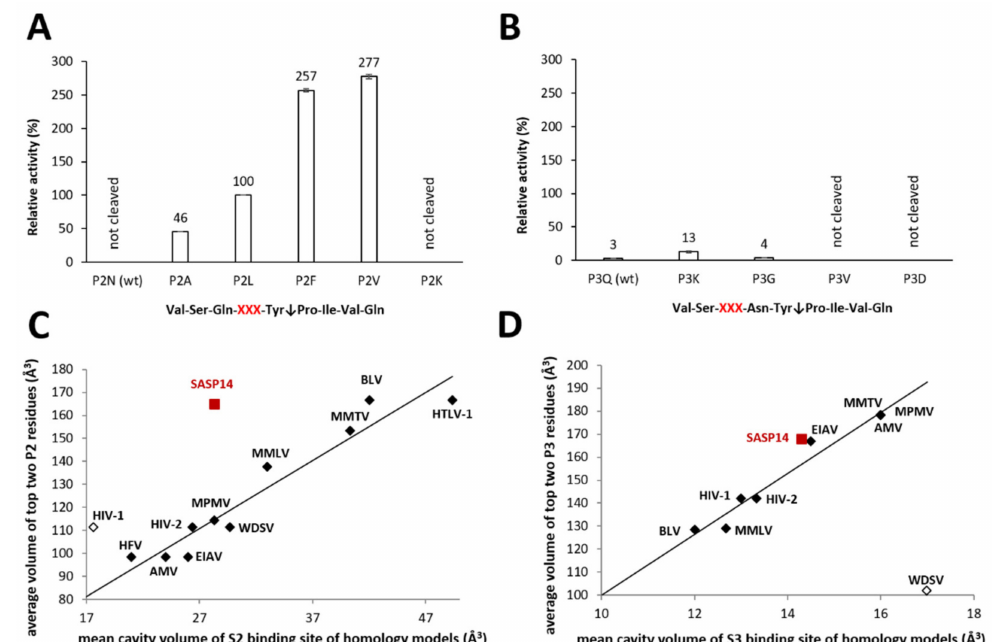
Figure 6. P2- and P3 residue preferences of GST-SASP14. The synthetic oligopeptides used for activity measurements represented wild-type and P2- or P3-modified variants of HIV-1 MA / CA (VSQNY ↓ PIVQ) cleavage site, modified positions are indicated by XXX. Relative activities were determined for the wild-type substrate and for its P2- ( A ) and P3-modified variants ( B ) by incubating reaction mixtures for 1 and 16 h, respectively. Activity determined for P2-Leu variant was considered to be 100%. Error bars indicate SD ( n = 2). Figure part ( C , D ) was prepared in part based on previously published data [24,25]: the average volumes of two residues for which the measured relative activity was the highest are plotted against the mean cavity volumes of S2 ( C ) and S3 subsites ( D ) of various retroviral proteases. Values determined for SASP14 are shown by red squares, values of previously published dataset are shown by diamonds. The black symbols show values that were used for correlation, while opened diamonds indicate values excluded from the former analysis. For SASP14, average residue volumes of top P2 residues (Phe and Val) of the cleaved substrates are shown ( C ), whereas volume of Lys is plotted against the mean cavity volume of P3 binding site ( D ). Additionally, compositions of the S2 and S3 substrate-binding cavities are shown in Table